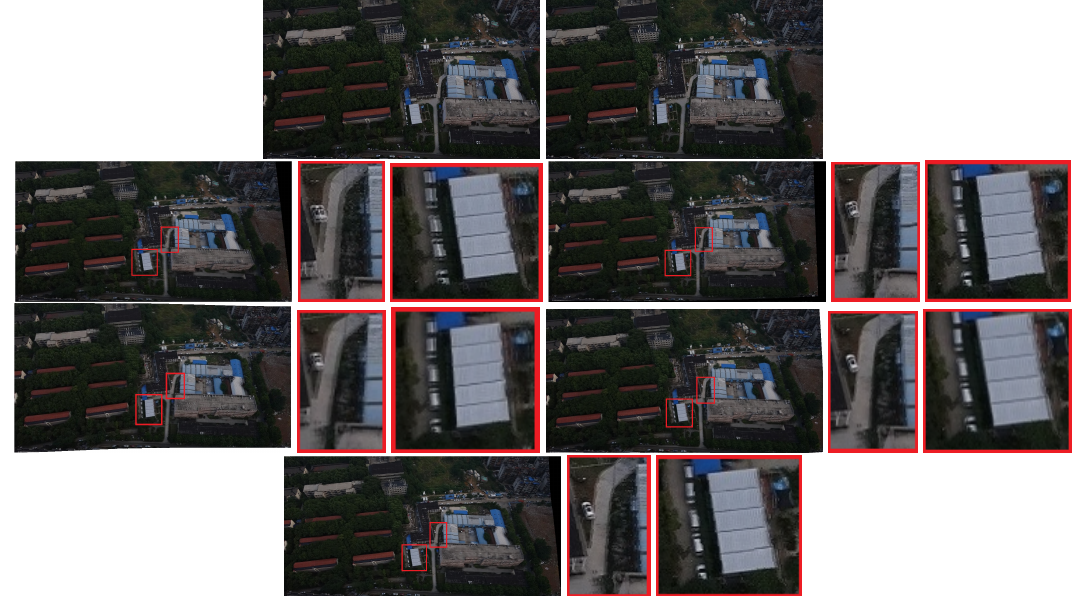
Figure 6. Qualitative comparison on UAV image mosaic. The first row is the two images to be stitched. The second and third rows are the stitching results of Autostitch [4], AANAP [41], SPHP [40], and PT [54]. Our result is shown in the last row. Red boxes highlight the ghostly